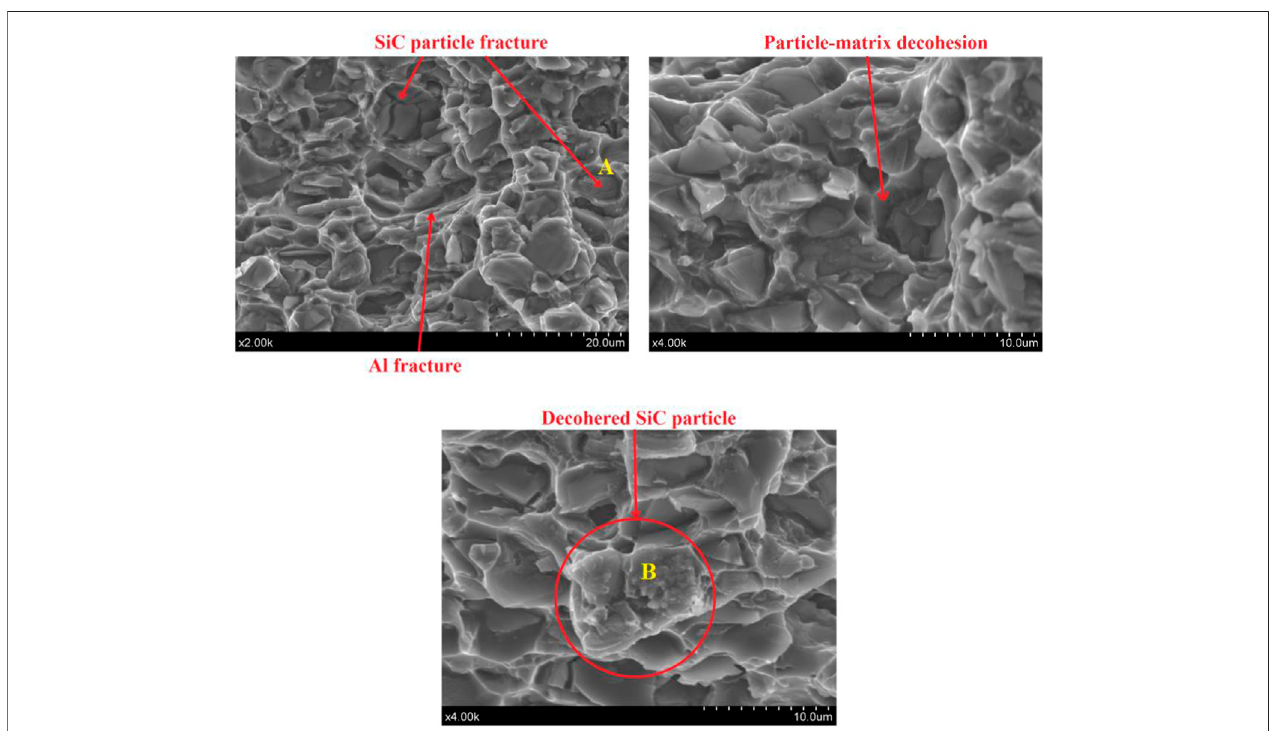
FIGURE 10 | SEM secondary electron micrographs of fracture surface of